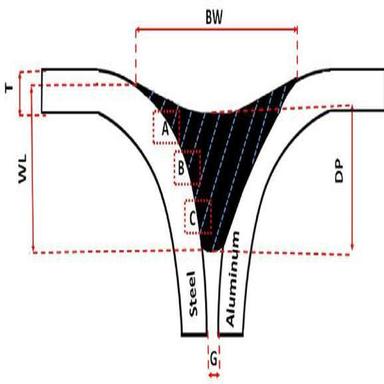
Schematic diagram of the joint (DP - Depth of penetration, BW - Bead width, WL - Wetting length of laser brazed joint, T - Thickness of the plate and G - Gap between the sheets).